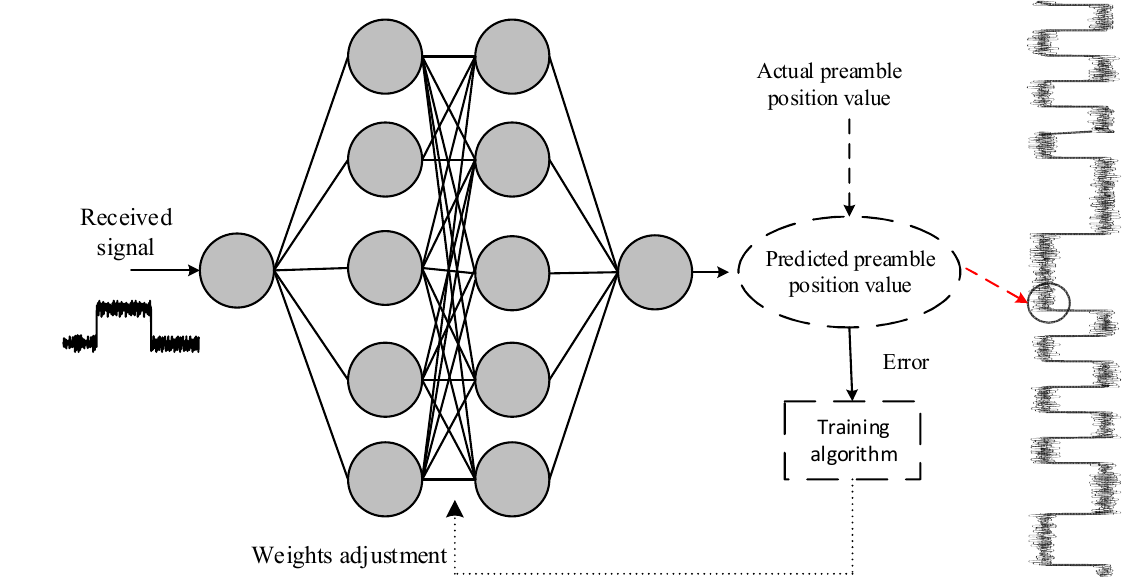
Figure 3. The deep learning neural network model for preamble detection.